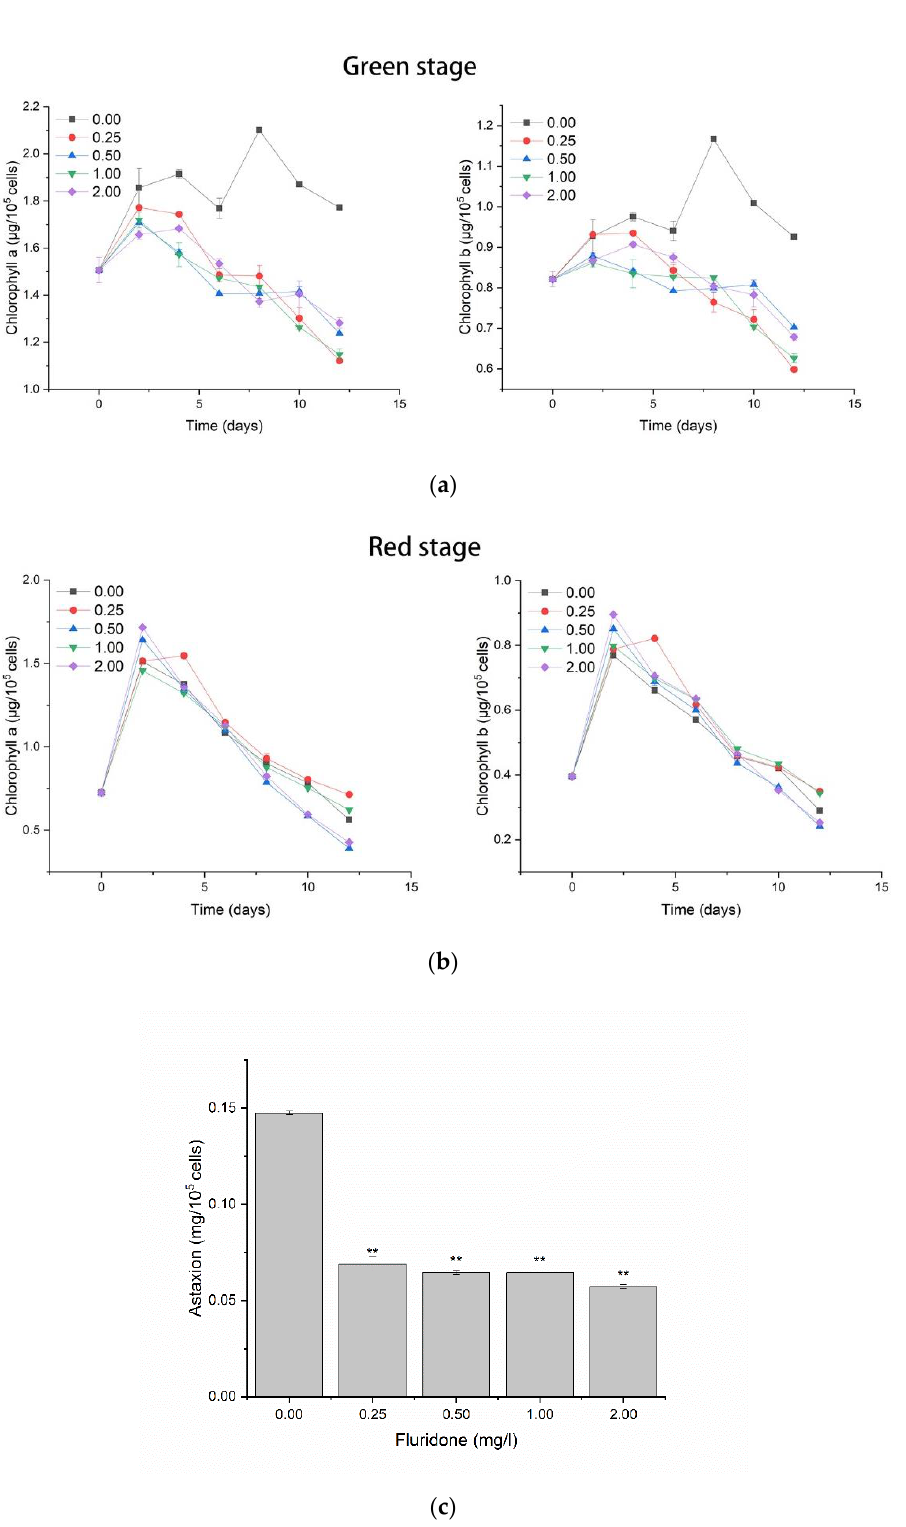
Figure 2. Changes in the content of three pigments after fluridone treatment. ( a ) Changes of chlorophyll a ( left ) and chlorophyll b ( right ) in the green stage, the lines with different colors indicate fluridone concentrations of 0.00mg/L, 0.25mg/L, 0.50mg/L, 1.00mg/L, and 2.00 mg/L. The abscissa represents different days, the same below. ( b ) Changes in chlorophyll a ( left ) and chlorophyll b ( right ) in the red stage. ( c ) Astaxanthin content after 12 days of induction treatment, ** indicates a significant difference from the control